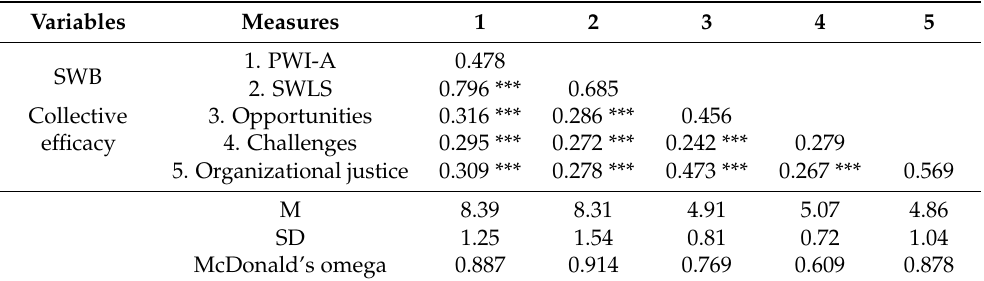
Table 1. Descriptive Statistics, correlation matrix, and average variance extracted (AVE) for study variables ( n = 693).